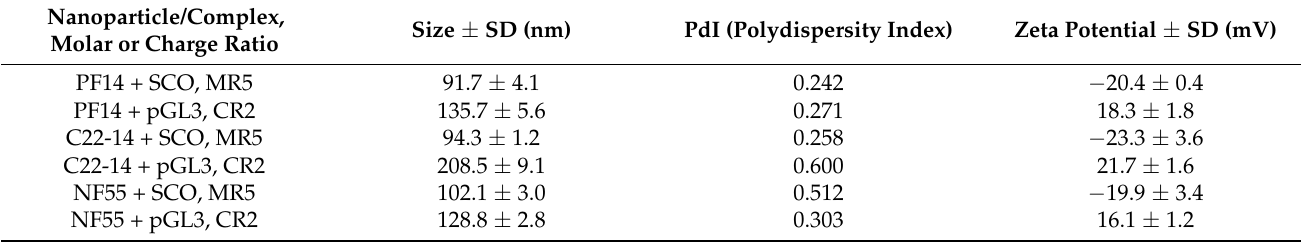
Table 2. Hydrodynamic diameter of CPP-nucleic acid nanoparticles in water, and zeta potential in 1 mM NaCl. Nanoparticle/Complex, Molar or Charge